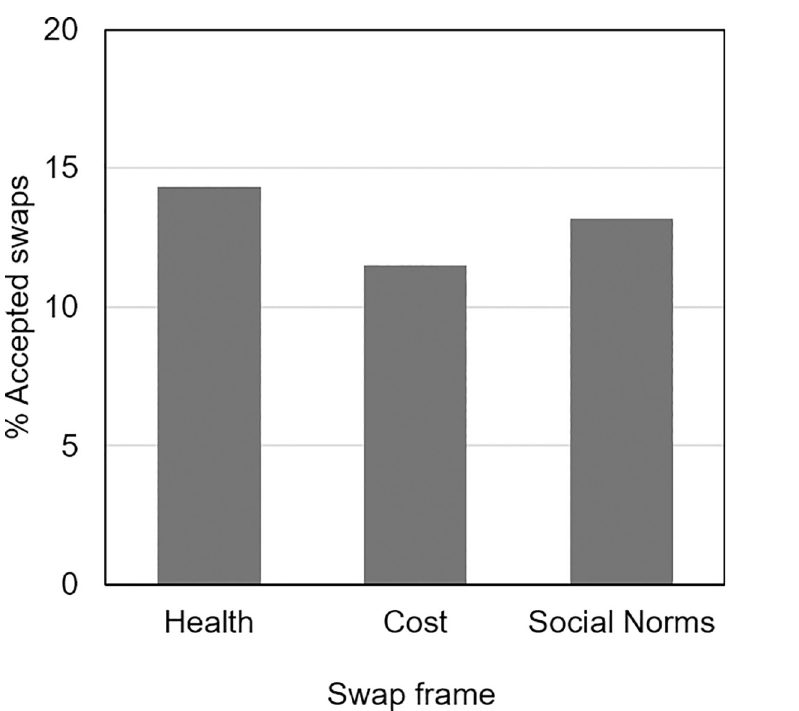
Fig 2. Percentage of swap offers accepted by swap frame